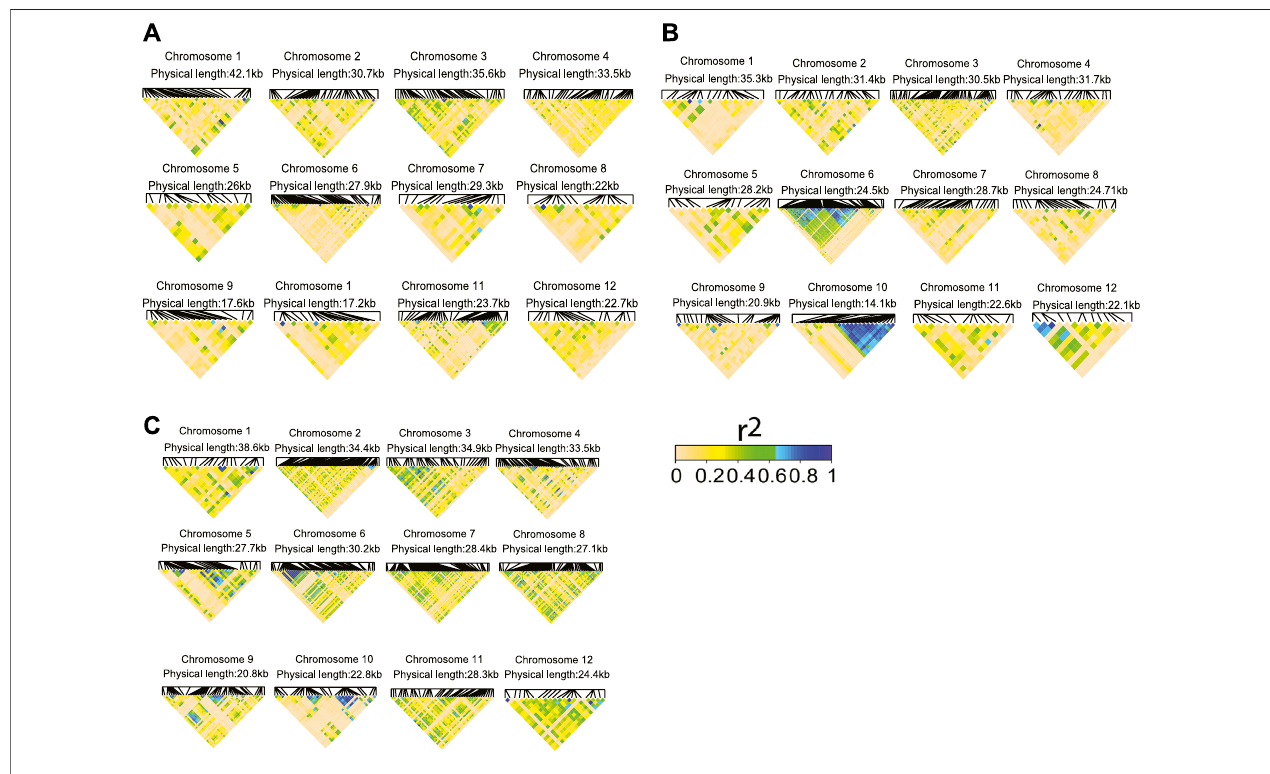
FIGURE 6 | Linkage disequilibrium (LD, r 2 ) heatmaps for the trait-associated SNPs (TA-SNPs, p < 0.01) identi fi ed from a genome-wide association study (GWAS) using the total population for (A) Zn, (B) Cu, and (C) Cd. The physical distance indicates the distance between the fi rst and last TA-SNPs found on each chromosome.